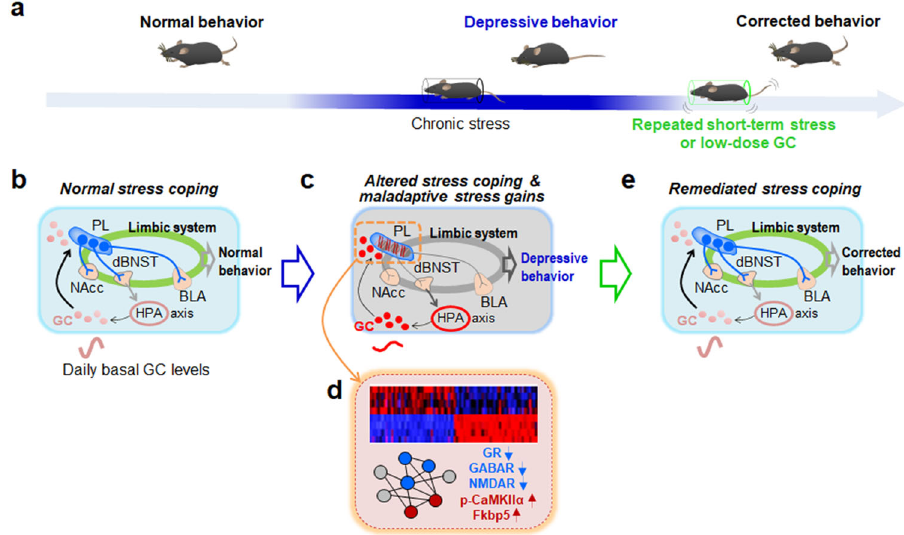
Fig. 10 A summary and hypothetical model for the recovery of maladaptively accumulated stress gains by treatment with short-term behavioral stress or low-dose GC. a Chronic stress produces maladaptive changes in the brain and persistent depressive behavior. Repeated treatment with short-term behavioral stress or low-dose GC reverses the stress-induced maladaptive changes and rescues depressive behavior. b Diagram showing the brain with the normal activity of PL outputs (PL → NAcc, PL → dBNST, and PL → BLA) and the limbic system (green), and normal activity of the HPA axis including the basal GC release at a normal circadian cycle and its feedforward effects on the PL. c , d Chronic stress overstimulates the PL primarily due to increased GC ( c ), which results in genome-wide gene expression alteration ( d ). As a result, the neural activity of PL outputs (PL → NAcc, PL → dBNST, and PL → BLA) and those of the associated limbic system are altered, and the basal GC release is enhanced and trailed off from a normal circadian cycle ( c ). Heatmap presents stress-induced genomic changes and their reversal by RS5. The expression levels of GR, GABAR, NMDAR, p-CaMKII α , and Fkbp5 in the PL are up- or down-regulated after chronic stress ( d ), and their physiological effects on depressive behavior are characterized in the present study. e Repeated treatment with short-term behavioral stress or low-dose GC reverses the disrupted neural activity of PL neurons, the altered gene expression pro fi les, and the altered activity of the HPA axis including GC release, and recti fi es the impaired feedforward effects of GC on the